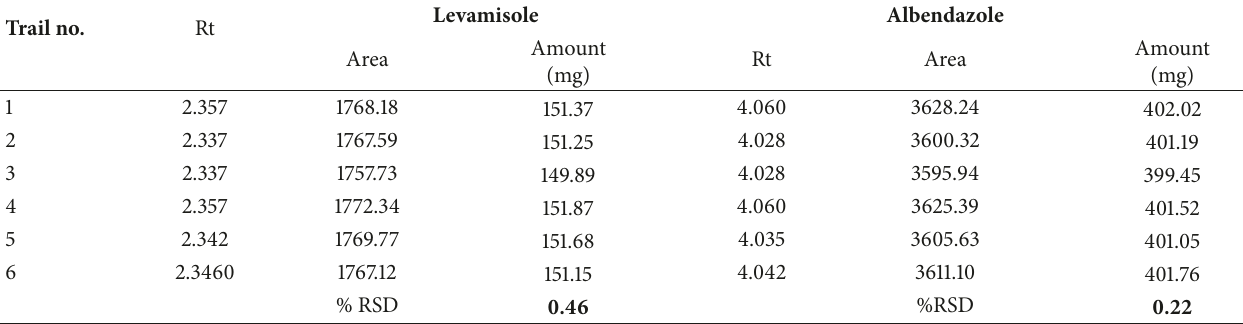
Table 4: Results of intra-assay precision studies of levamisole and albendazole.